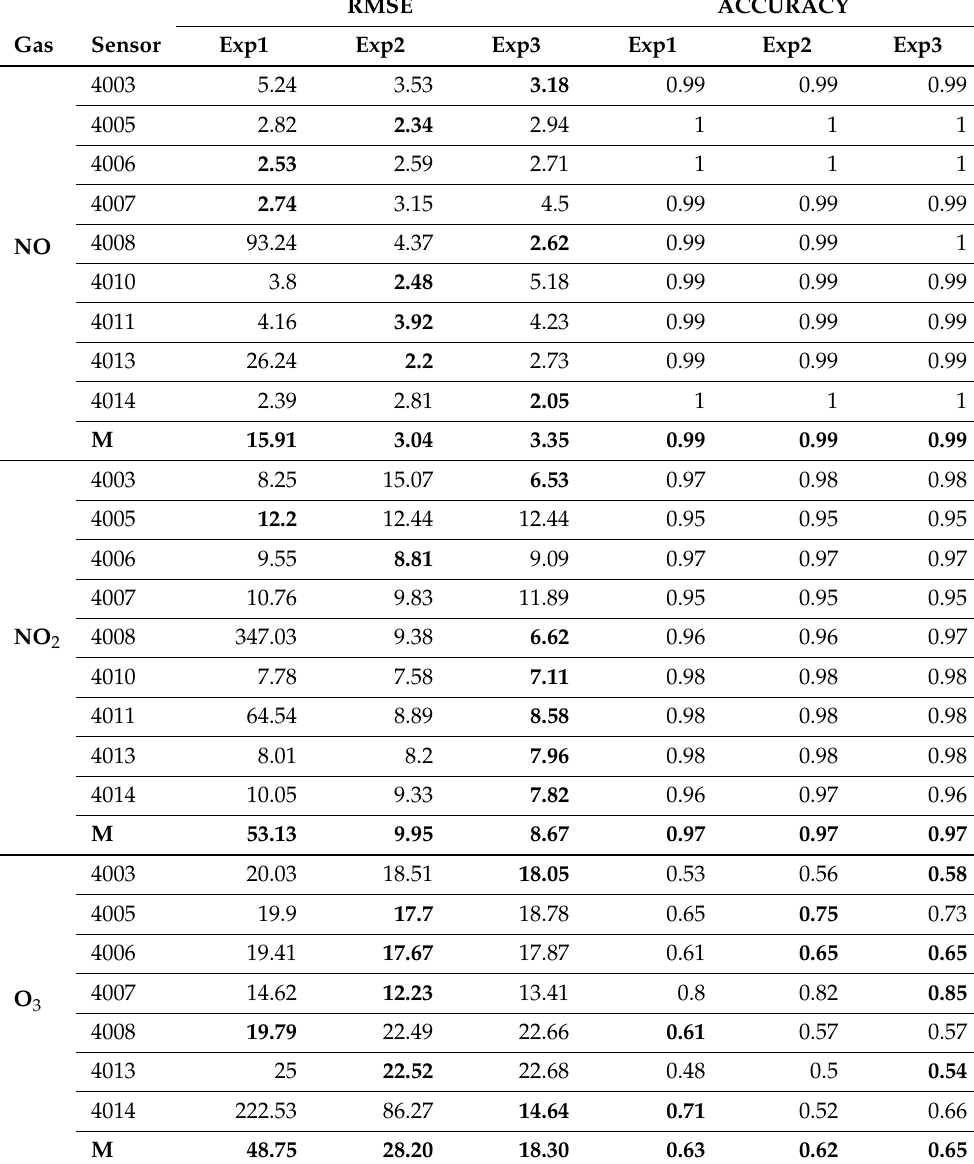
Table 3. Experimental